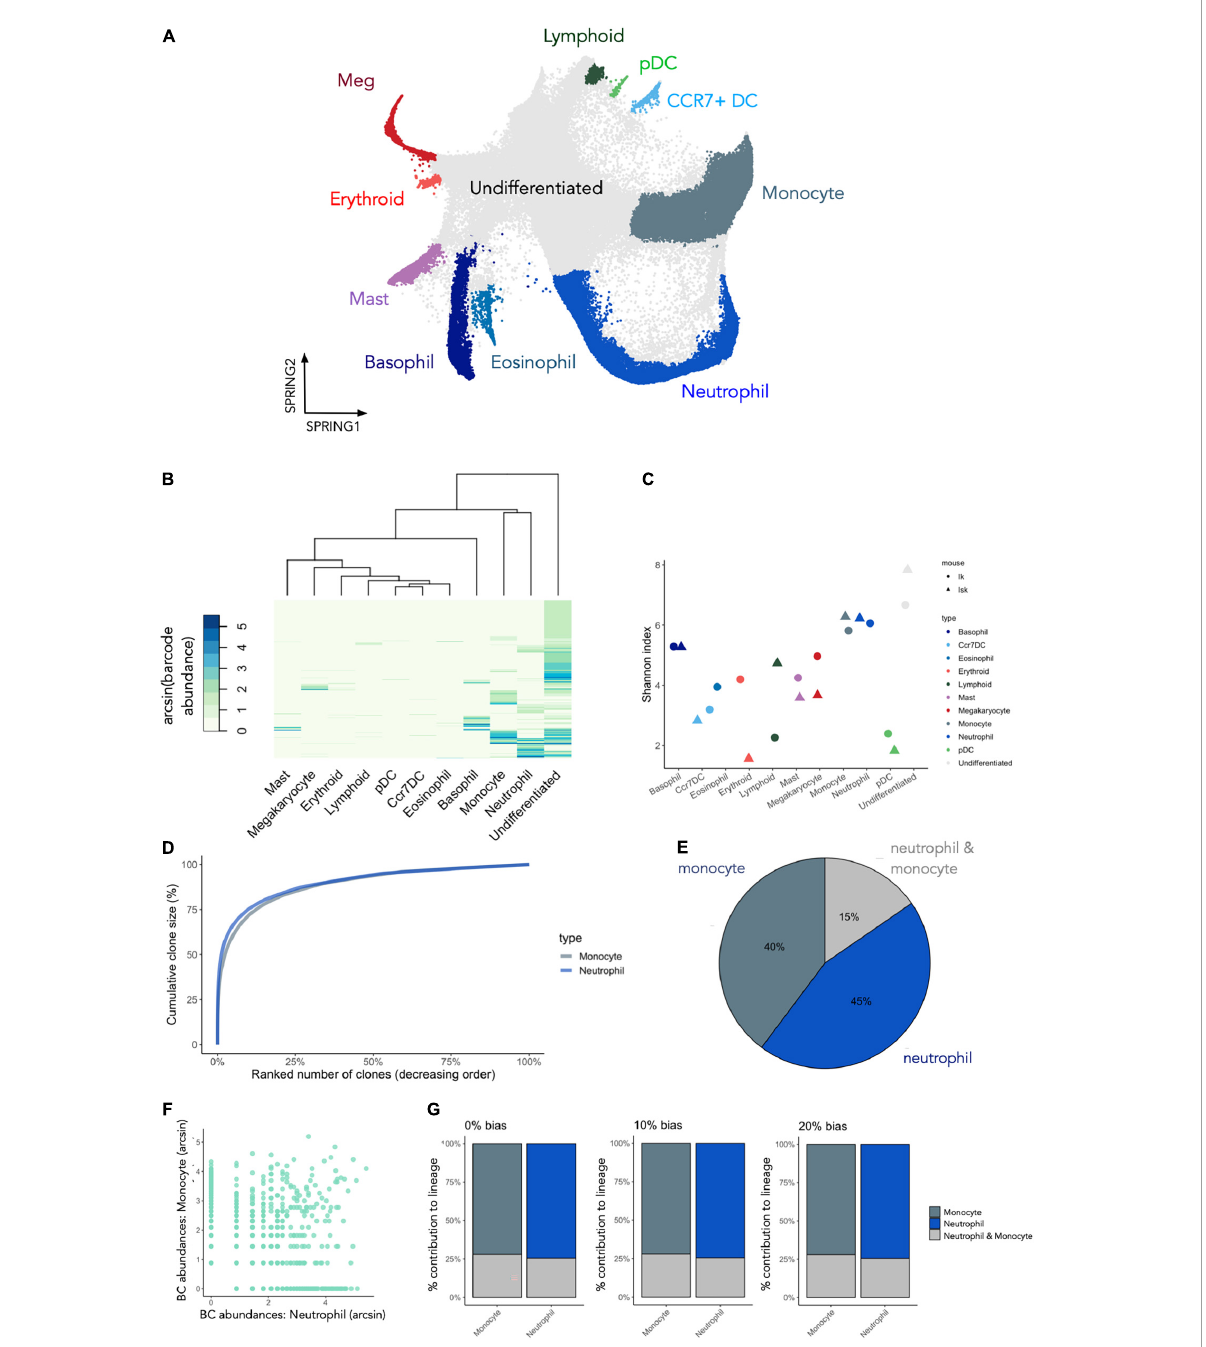
FIGURE10 Using CellDestiny to analyze datasets with transcriptomic and cellular barcoding measurements of single cells. (A) a UMAP visualization of gene expression data for cKit+ (LK) and cKit+ Sca1+ (LSK) murine bone marrow cells that were barcoded and then differentiated in vitro . Each color represents a distinct cell type as designated by the authors of the original study. These cell type references were used to generate a count matrix by tallying the number of times each barcode occurs in each cell type (B) Hierarchical clustering of the lineage tracing data using CellDestiny using Euclidian distance and complete linkage. Colors represent the arcsin transformed number of cells per barcode per cell type. (C) Shannon diversity measures for all cell types. Each cell-type is represented with two points, with each point representing either the LK or LSK starting cell population (D) cumulative clone-size distributions for the monocyte and neutrophil clusters. (E) The proportion of barcodes that are unique to, or shared between the monocyte and neutrophil clusters. (F) A scatterplot of arcsin transformed barcode abundances for the monocyte and neutrophil clusters for LSK and LK subsets of the data. (G) Lineage bias classifier results for barcodes of the neutrophil and monocyte cell types using 0 and 20% thresholds. N = 3 experiments, N = 5865